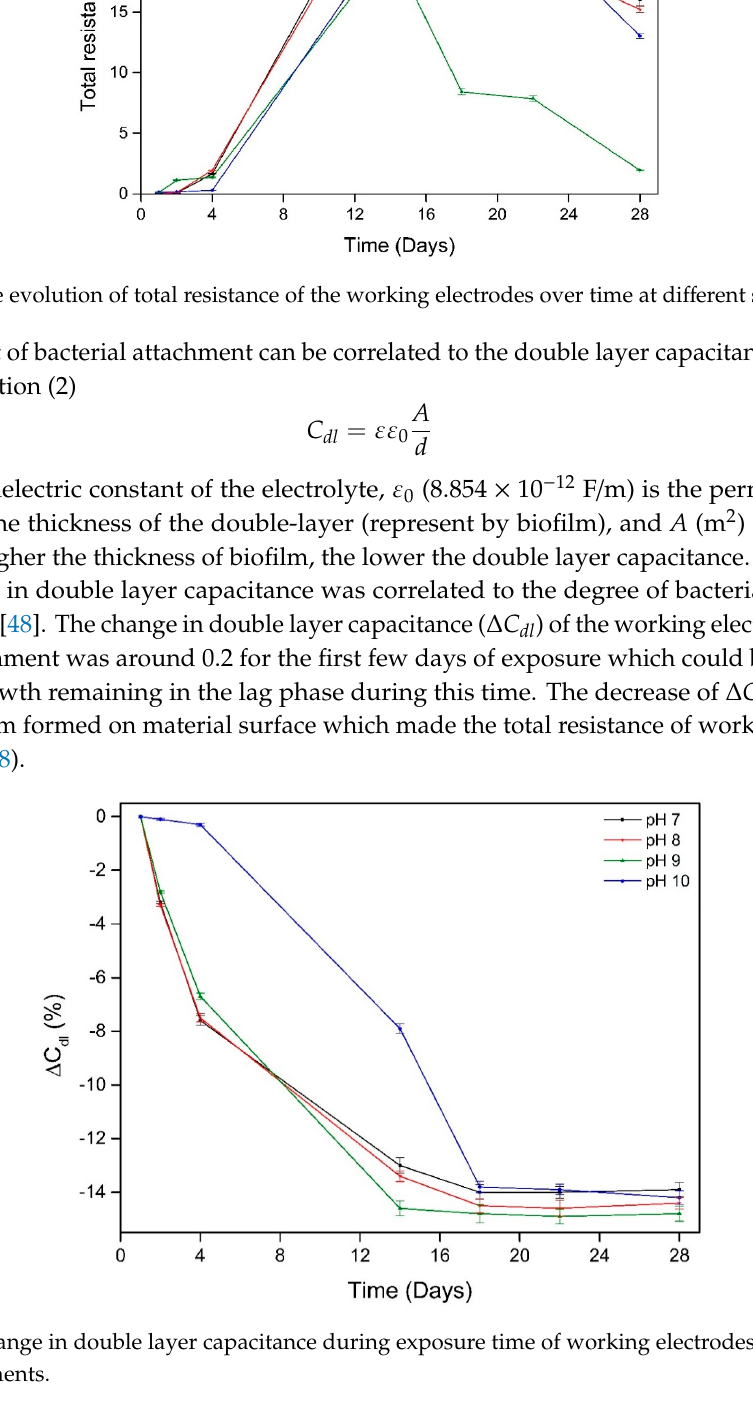
Figure 9. Potentiodynamic polarization curve of working electrode in different pH environments.